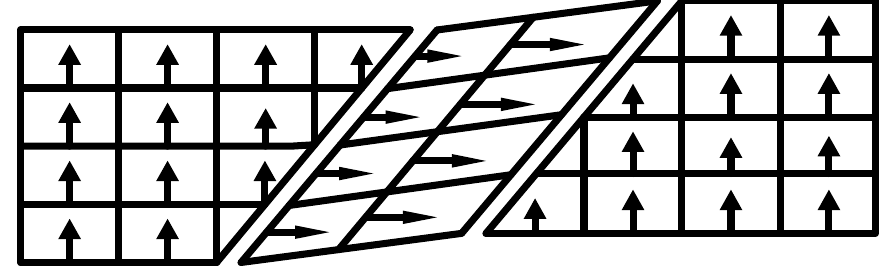
Figure 3. Piezoelectric crystal domain diagram.